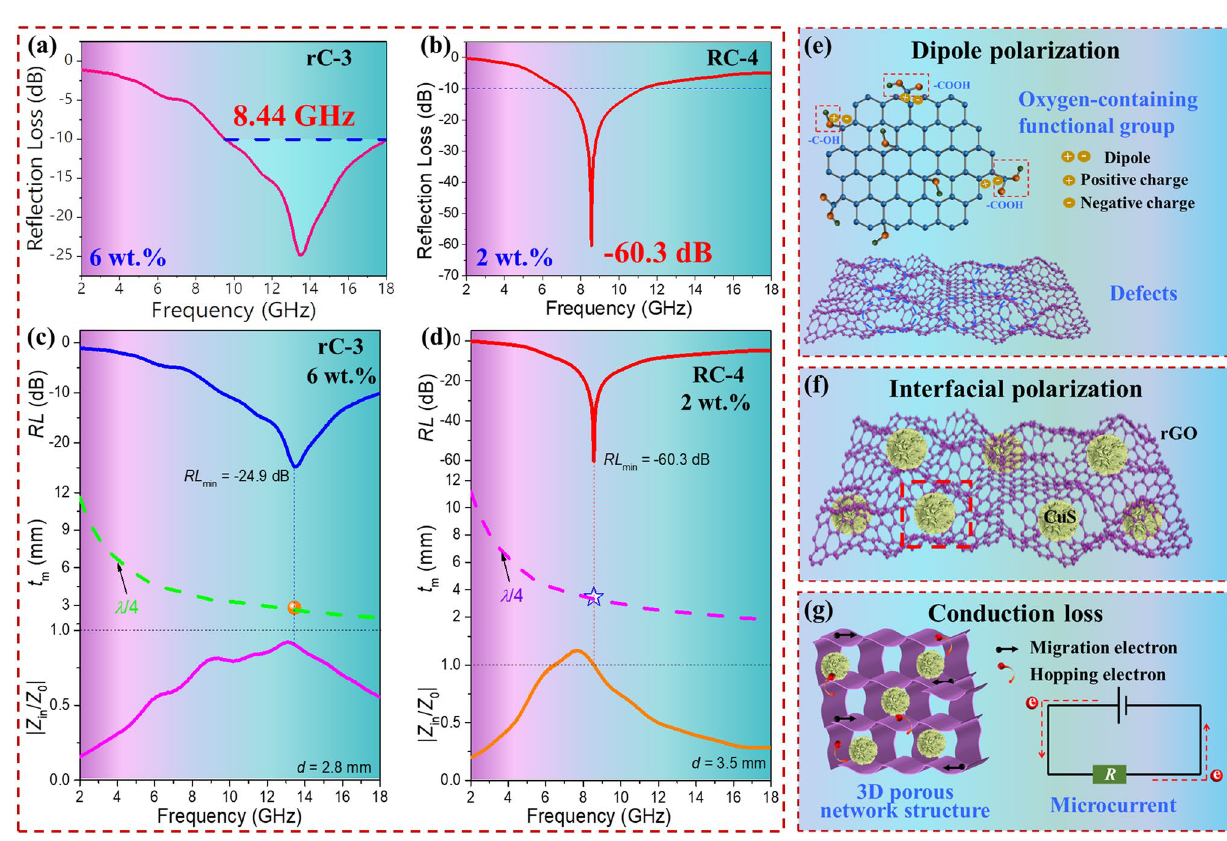
Fig. 5 a RL ~ f curve of rC-3 with the broadest EAB at 2.8 mm. b RL ~ f curve of RC-4 with the RL min at 3.5 mm. RL, t m and | Z in / Z 0 | curves: c rC-3 and d RC-4. Possible MA mechanism of CuS@rGO composite aerogels: e dipole polarization, f interfacial polarization and g conduction